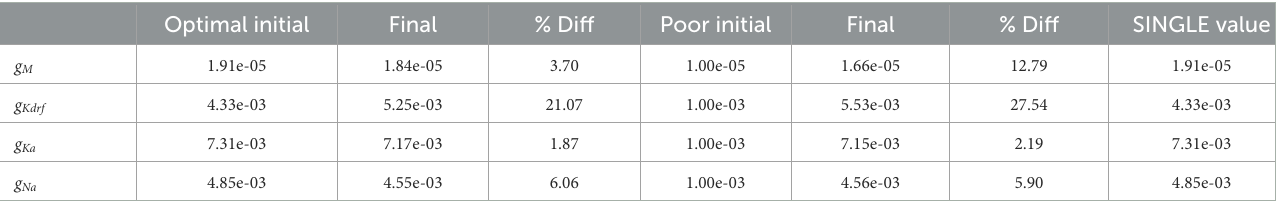
TABLE 3 Using FULL for experimental